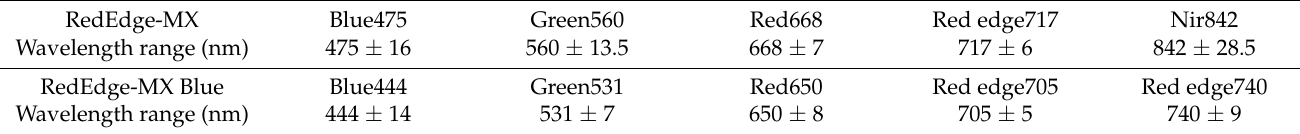
Table 2. Band ranges of RedEdge MX